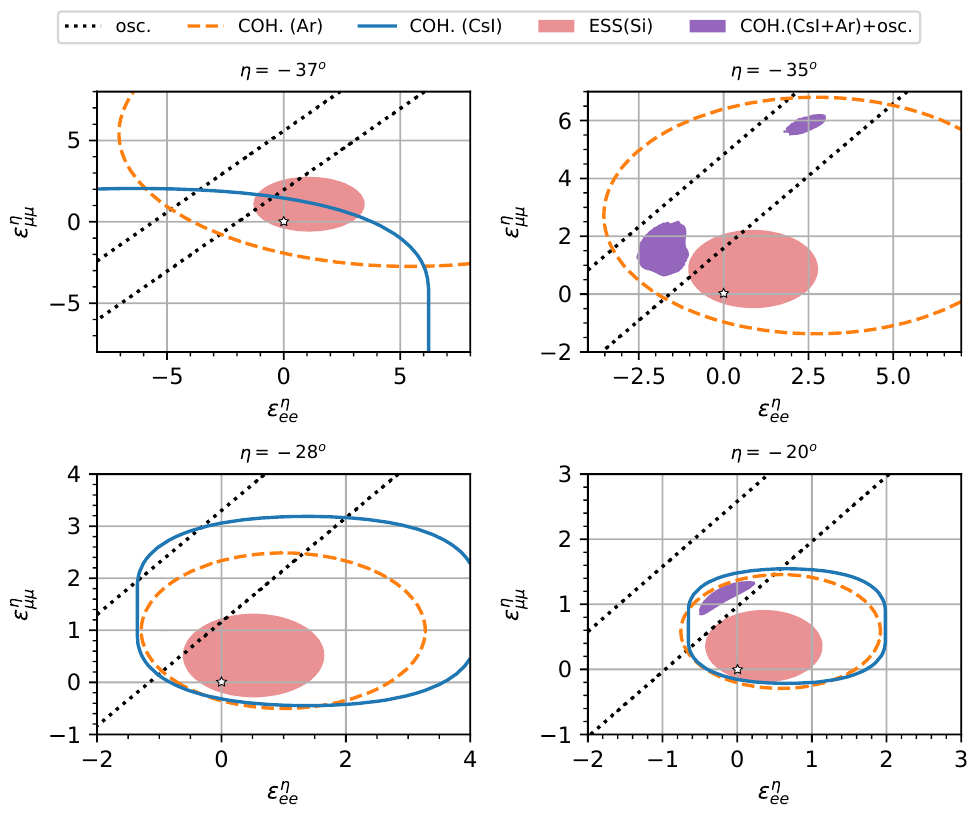
Figure 3 . Same as figure 2 but minimizing with respect to the off-diagonal (cid:15) η